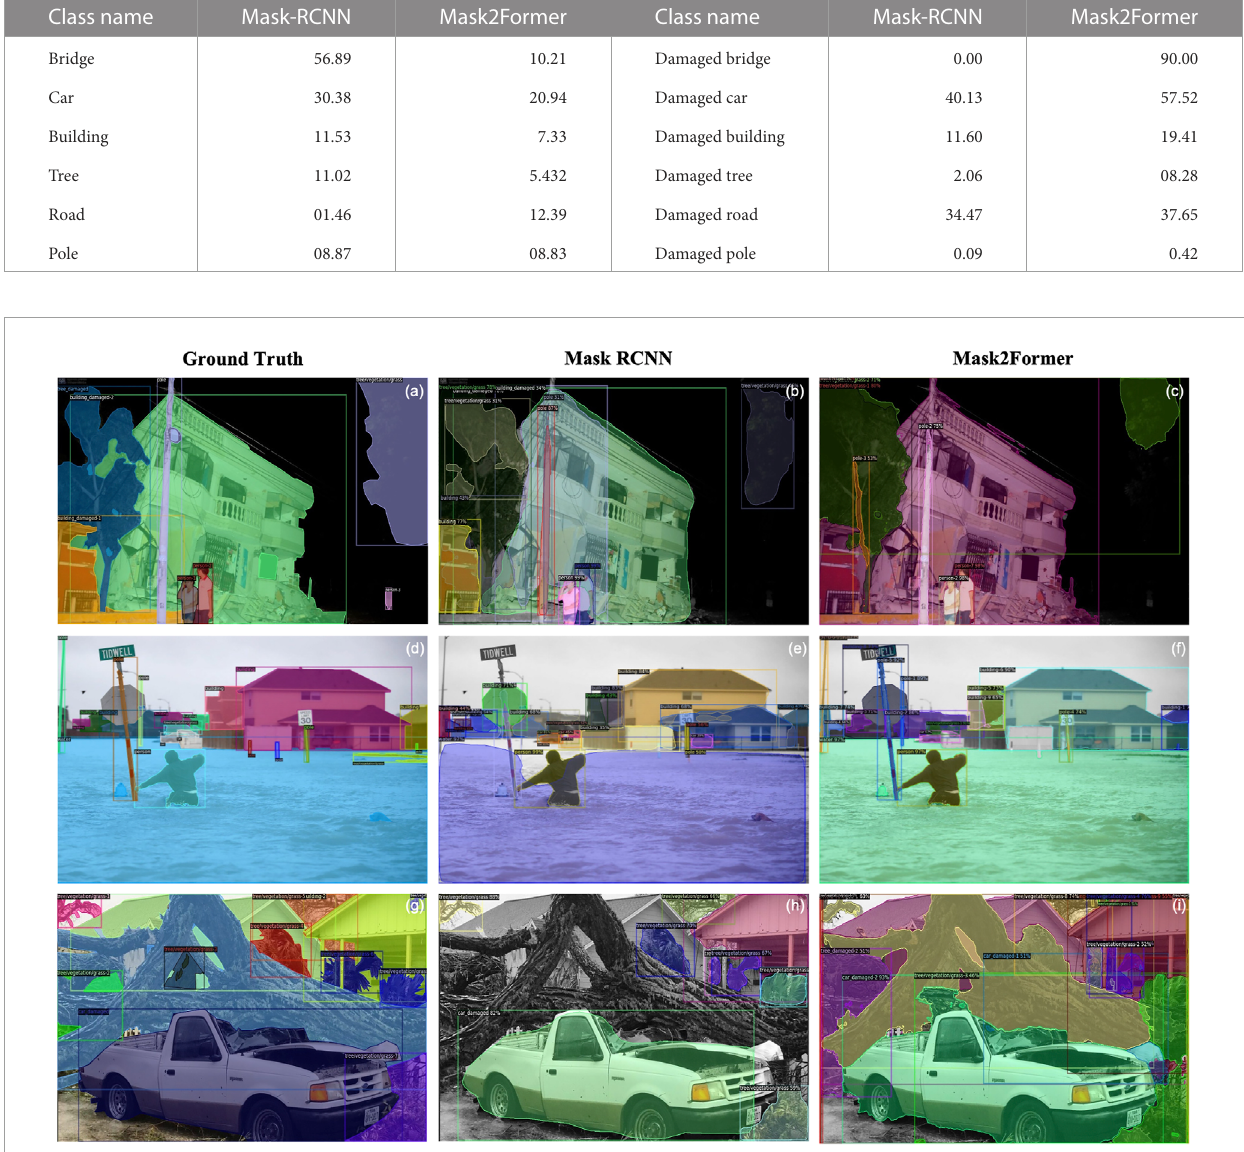
FIGURE 3 Ground-truth annotations (A,D and G) ; Mask-RCNN instance segmentation model predictions (B,E and H) ; Mask2Former instance segmentation model predictions (C,F and I)